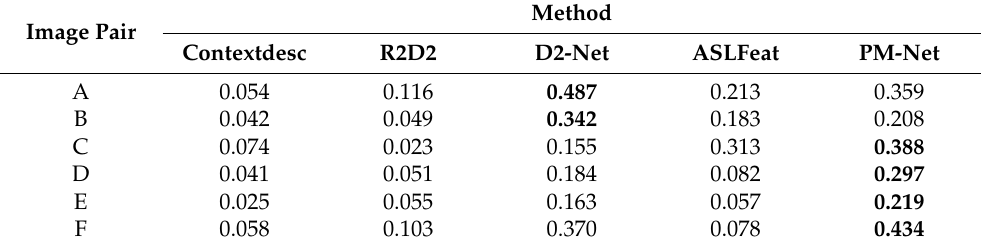
Table 2. Values of F1-measure.